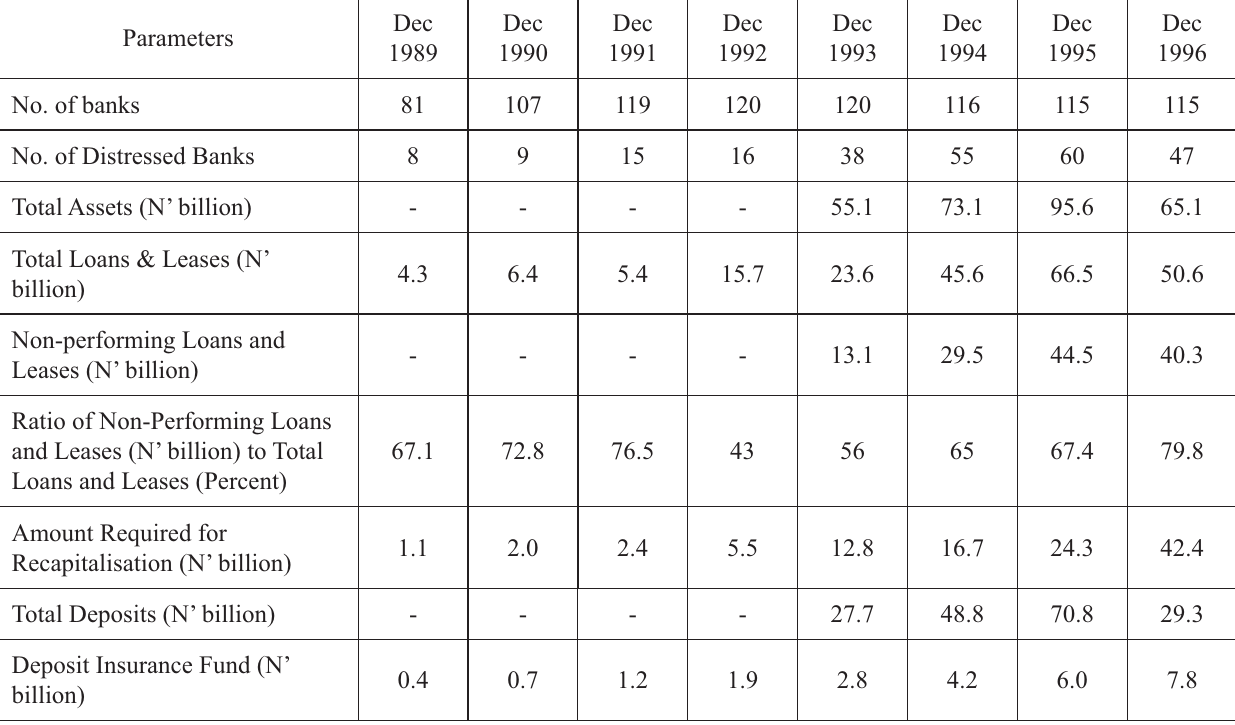
Table 1. Level of Distress in the Nigerian Banking System